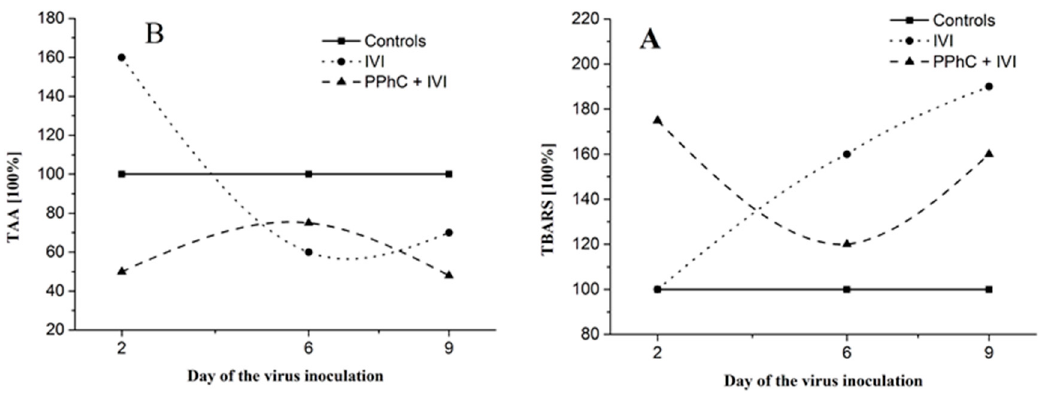
Figure 6. The effects of IVI on the lipid peroxidation measured by thiobarbituric acid reactive substances (TBARS) levels ( A ), and on TAA ( B ). The TBARS and TAA levels in the control plasma (without IVI) are expressed as 100%.